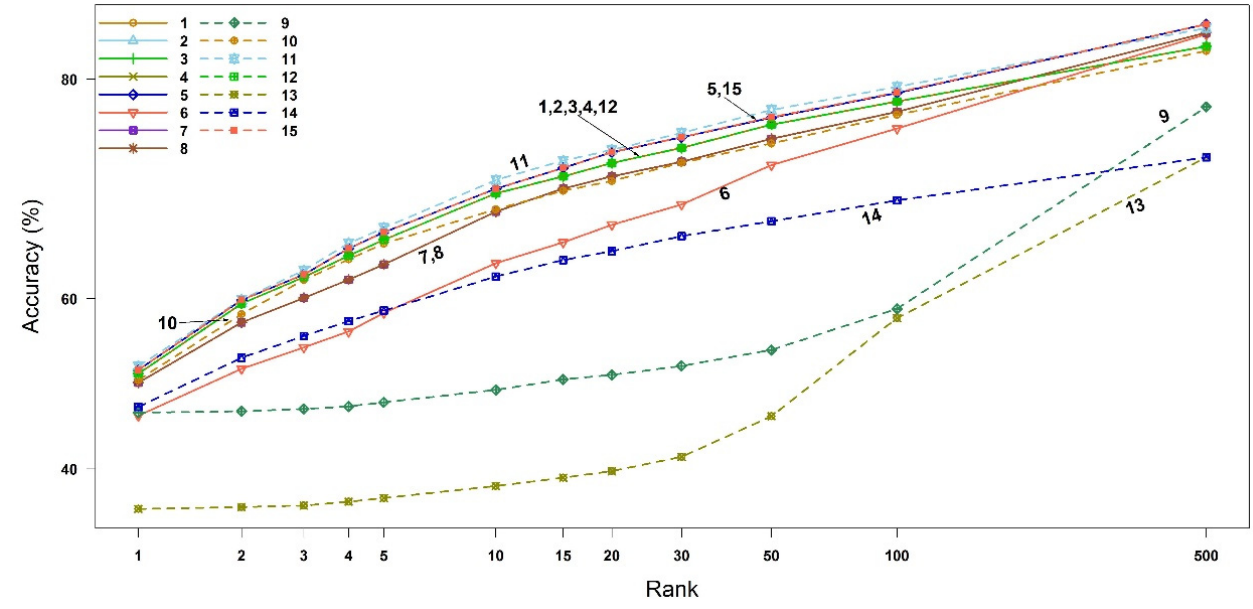
Figure 5. Accuracy of all similarity measures for ESI mass spectra-based compound identification by rank. The x -axis represents the ranks and the y -axis the identification accuracy. The numbers in legend and plot are the indices of binary similarity measures corresponding to Table 4 of Section 4. The binary similarity measures with the highest accuracy from each of the four clusters, which are measures 5 (Cosine), 7 (McConnaughey), 9 (Simpson), and 13 (Intersection), were chosen. Then, the consensus analyses of these four similarity measures were performed, using all of the reference compounds that were matched to query mass spectra (Figure 6b) and all of the reference compounds that were correctly matched (Figure 6c). Of these, measure 5 has the highest accuracy, followed by measures 7 and 9. Measure 13 has the lowest accuracy and detected the least unique compounds (3%; Figure 6b). As expected, measure 5 detected the most unique compounds (9%; Figure 6b) and the most unique true compounds (6%; Figure 6c). Measure 7 detected the least unique true compounds (1%; Figure